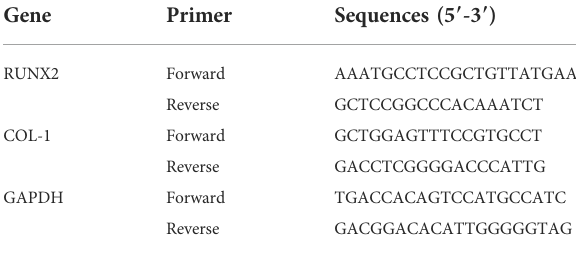
TABLE 2 Primer sequences used in the study.